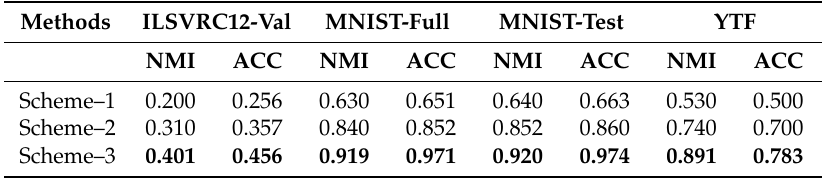
Table 5. Comparison between different Schemes of Proposed Method Based on Performance Measure (NMI & ACC).